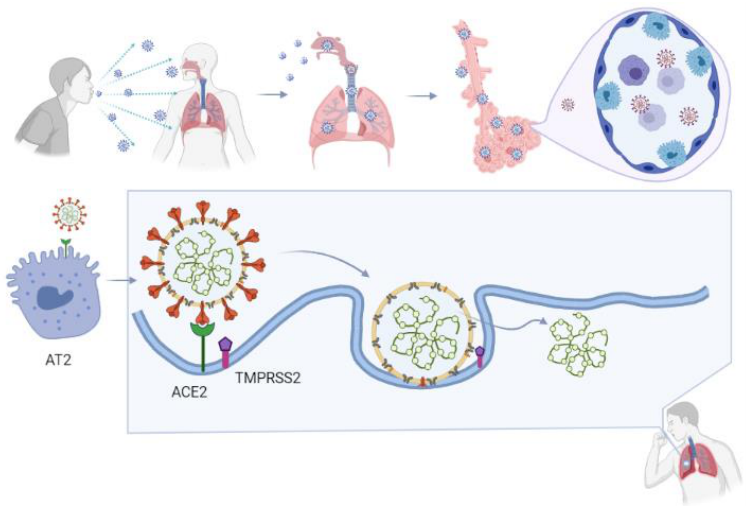
Figure 3. SARS-CoV-2 infection route. Infected COVID-19 patients can spread the virus by sneez- ing or coughing, or by any other route that drops the infectious particles onto another surface.